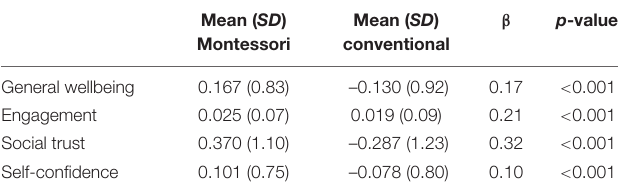
TABLE 6 | Means and SDs, standardized regression coefficients, and p -values for SEM.